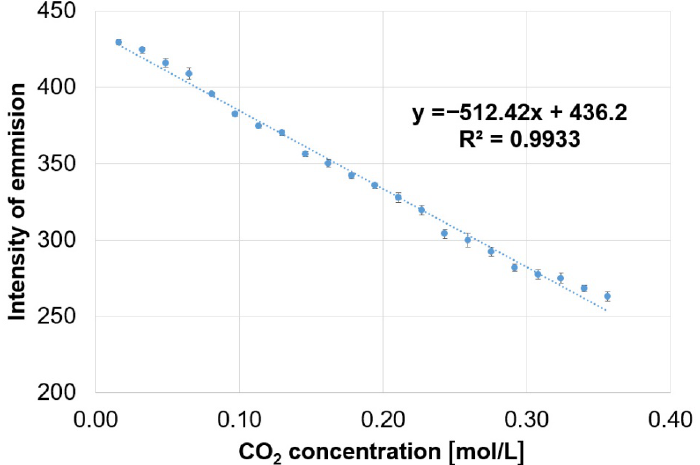
Figure 7. Linear dependence between the intensity of emission measured at 660 nm for the (5-COOH- 3MPP)-k-carrageenan during 60 min of CO 2 gas exposure (flow rate of 10 mL/min). A quantity of 1 g composite material that contains 0.09 g porphyrin can capture 6.97 mmol CO 2 . This result is six times lower than the best-reported result [9], which